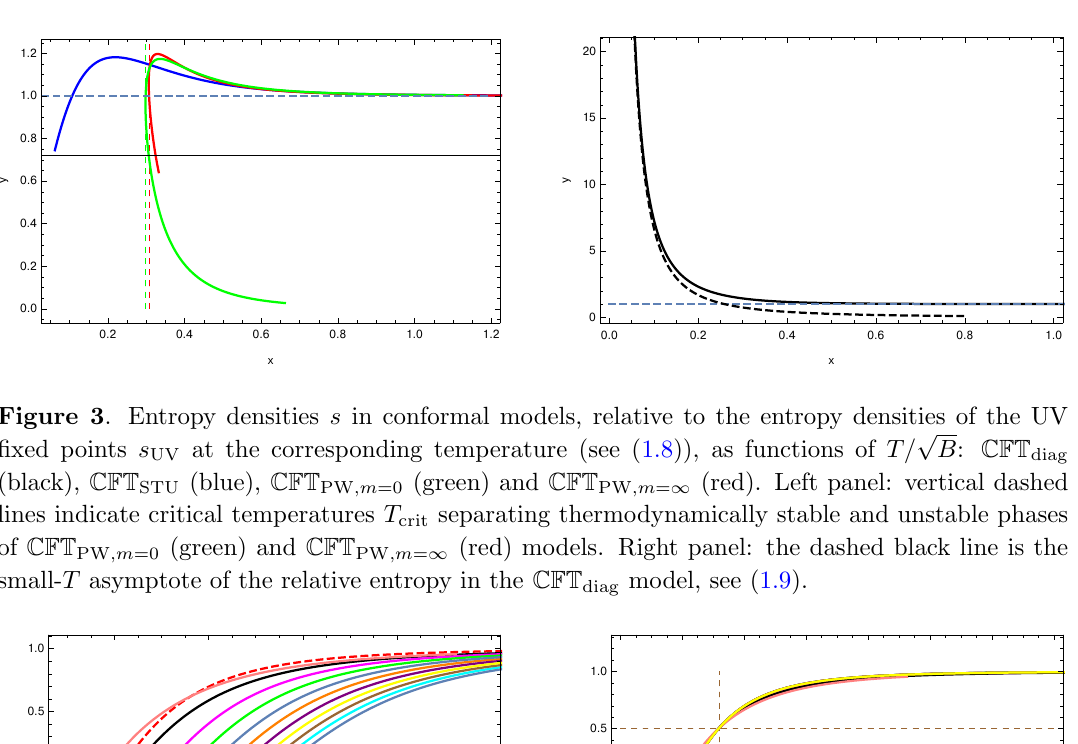
Figure 4 . Anisotropy parameter R = P T =P L for nonconformal models n CFT m for select values of p the hypermultiplet mass m , see (1.10), as a function of T= B (solid curves; from pink to dark blue as m increases). The dashed red curve is a benchmark model CFT PW ;m = 1 | where the anisotropy parameter is renormalization scale independent. In the left panel the renormalization scale is set (cid:14) = 4 for all n CFT m models; in the right panel it is separately adjusted for each n CFT m model to ensure that all the curves pass through the matching point, highlighted with dashed brown lines.